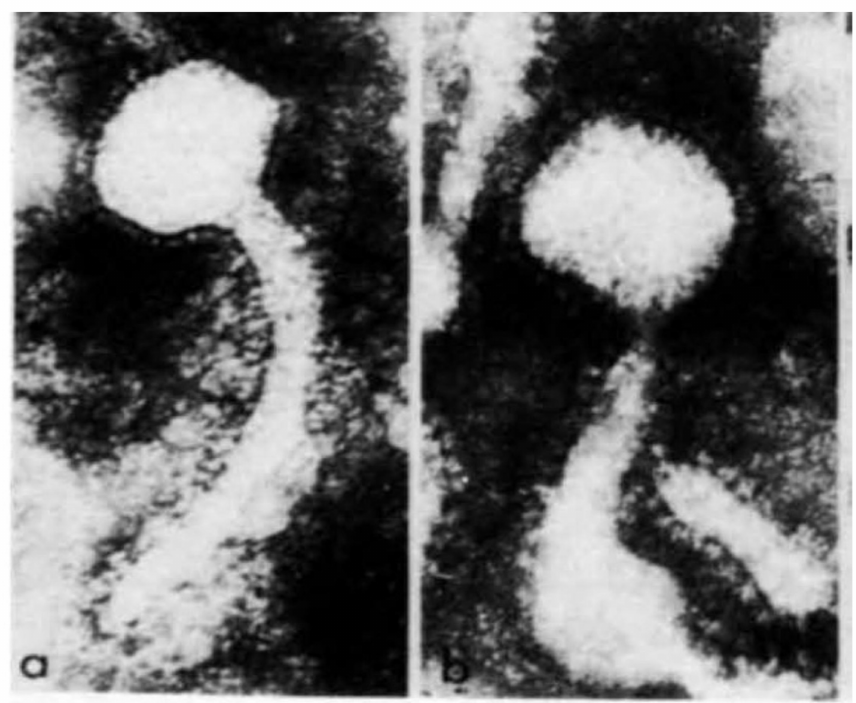
Figure 1. Particles found in human and mouse milk and in culture fluid. ( a ) Negatively stained parti- cle from American human milk; ( b ) Negatively stained particle from RIll mouse milk ( × 18,000) [18]. (Republished with copyright permission from Nature).